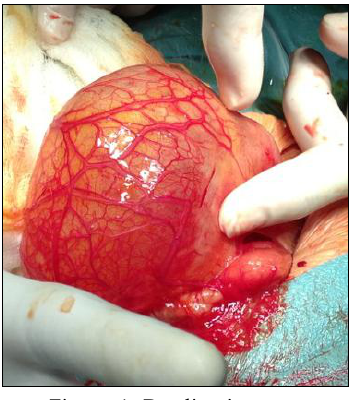
Figure 1: Duplication